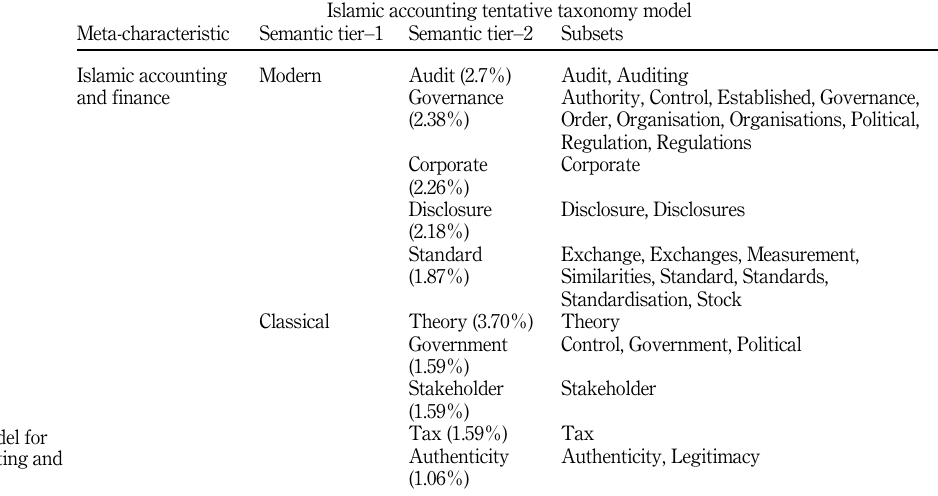
Table 2. Taxonomy model